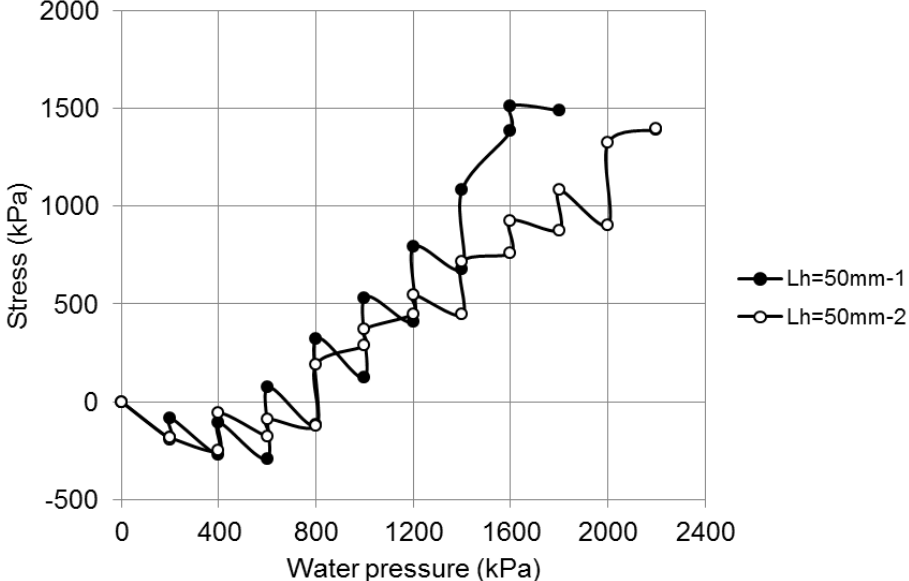
Figure 4. Induced average vertical stress of the semicircle crack specimen in the crack plane versus water pressure under the vertical displacement restraint conditions at 20 °C.